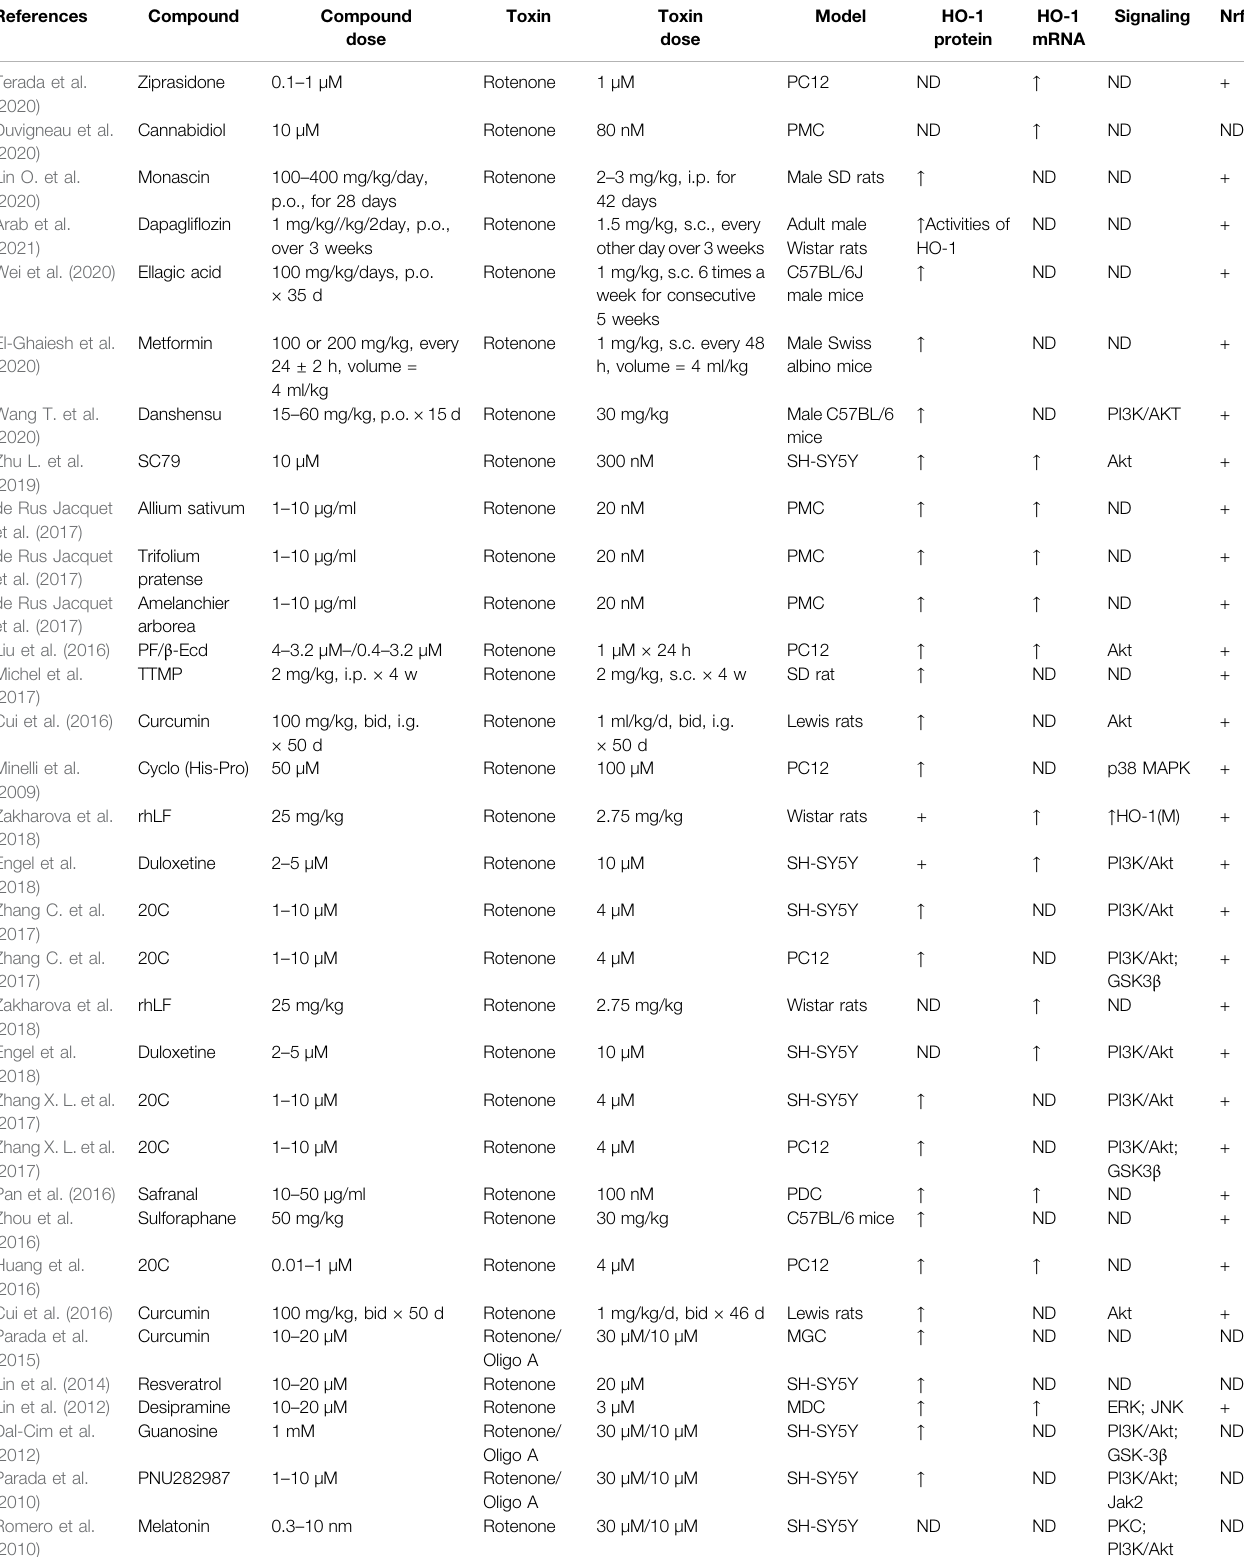
TABLE 11 | Summary of the experimental studies involving HO-1 inducer against rotenone-induced PD